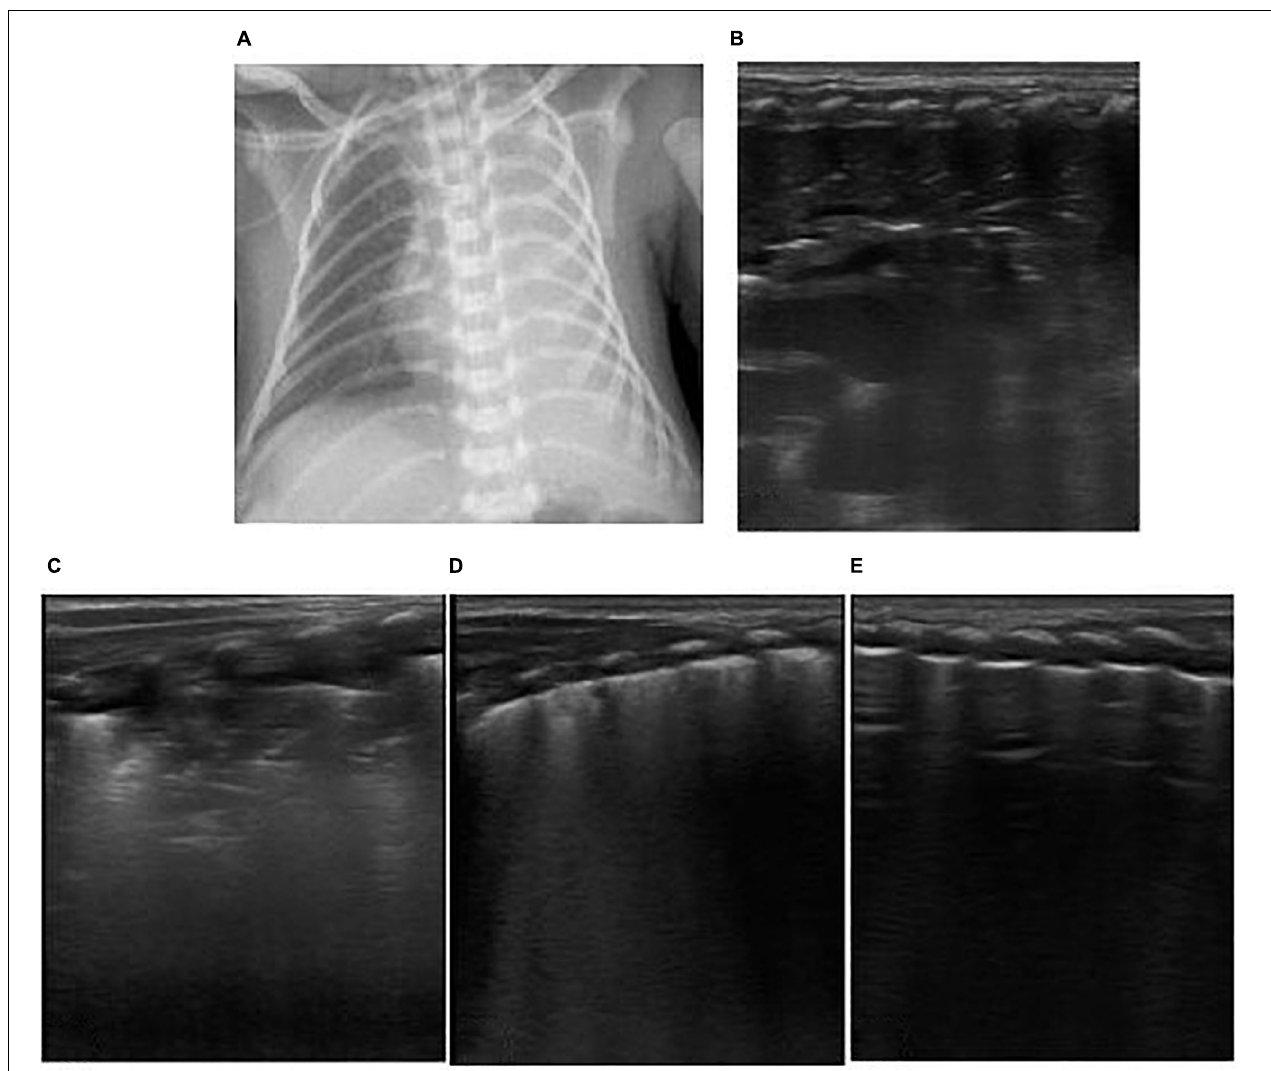
FIGURE 5 | The patient was born at 33 + 1 weeks of gestational age by Cesarean section due to the mother’s placenta previa and hemorrhagic shock, with an inborn weight of 1.75 kg and hemorrhagic amniotic fluid. The Apgar score of 1, 5, and 10 min of birth were 1, 7, and 7 points. The patient had pulmonary hemorrhage after delivery. Ventilator weaning was performed after 10 days of mechanical ventilation. After 2 days post-ventilator weaning, the patient had decreased blood oxygen and labored breathing. Mechanical ventilation was reperformed via endotracheal intubation. Emergency LUS showed that the left lung showed liver like echo, pleural line, and A line disappeared, dendritic bronchial inflation sign and pulmonary pulsation were visible, revealed left lung atelectasis (B) . Chest X-ray showed white lung changes in the left lung (A) . Lung recruitment was performed under ultrasound monitoring, and the range of consolidation was reduced gradually, and pleural line and A-lines were clear (C–E) . Lung ventilation improved, and finally, the ventilator was weaned.